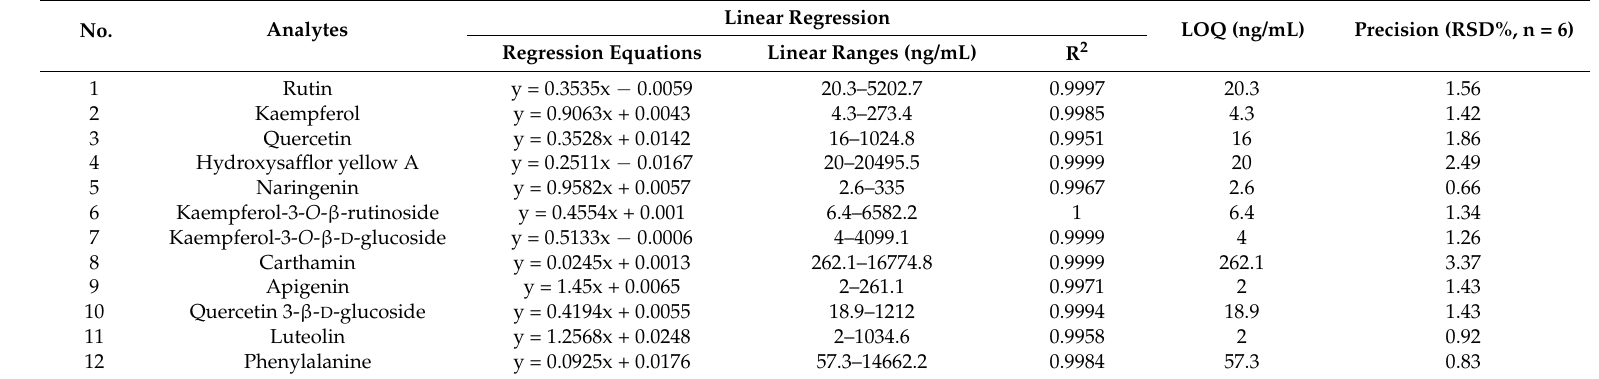
Table 2. Linear regression data of the investigated metabolites.